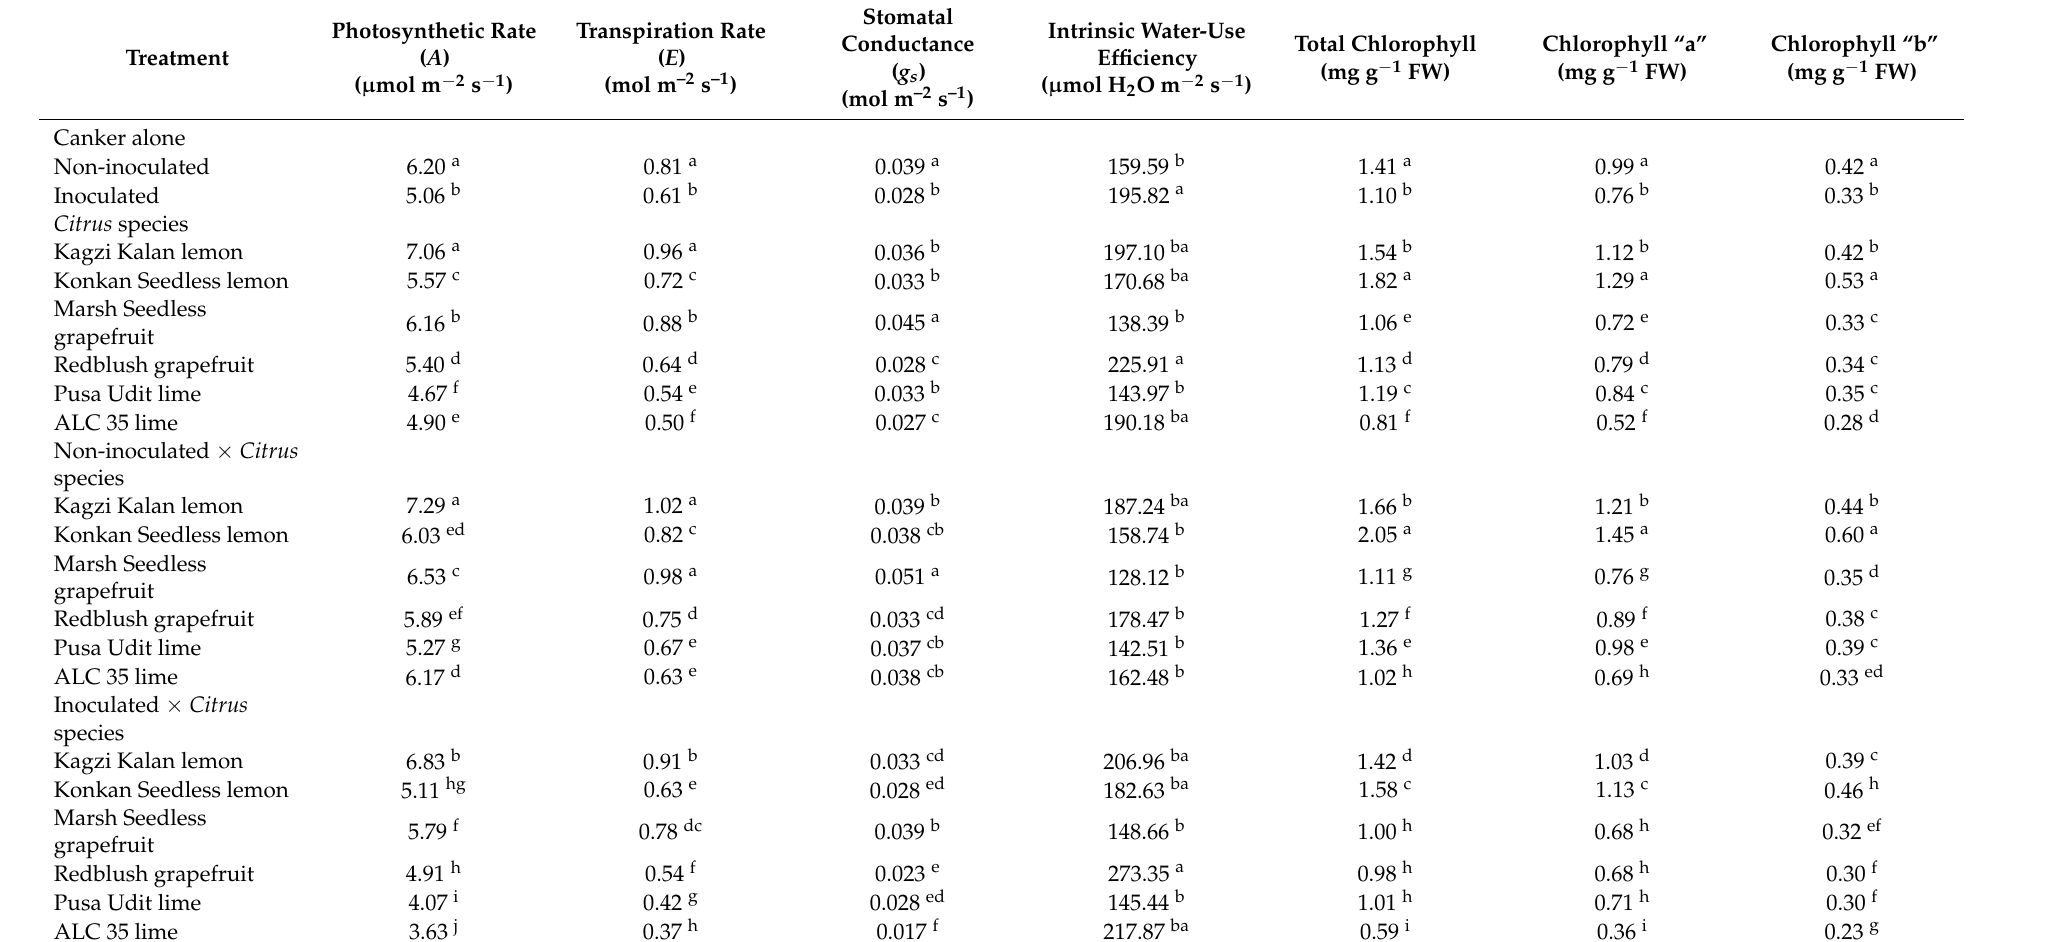
Table 1. Effect of X. citri pv. citri inoculation on leaf gas exchange and chlorophyll (total, “a”, and “b”) content of citrus